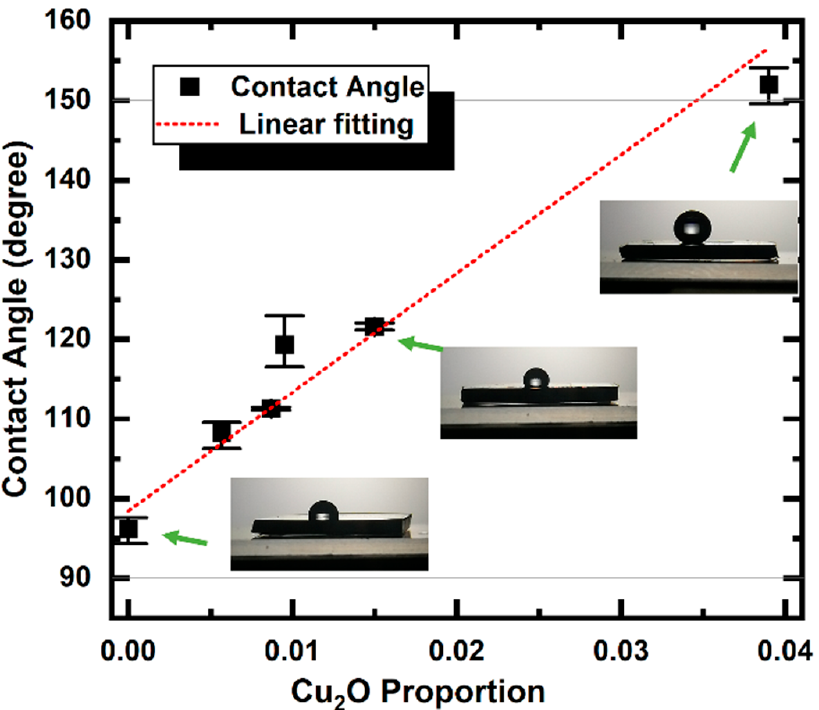
Figure 6. Contact angle, Sa, and Cu 2 O proportion of the pristine and laser ‐ irradiated samples. ( a ) 4 mm × 4 mm samples. ( b ) Previous sample with different experiment dates of CA and XRD. The droplets used for the CA measurement have a volume of 3 μ L. The CAs were automatically con ‐ firmed by pre ‐ installed software which can automatically detect the edge of droplets.